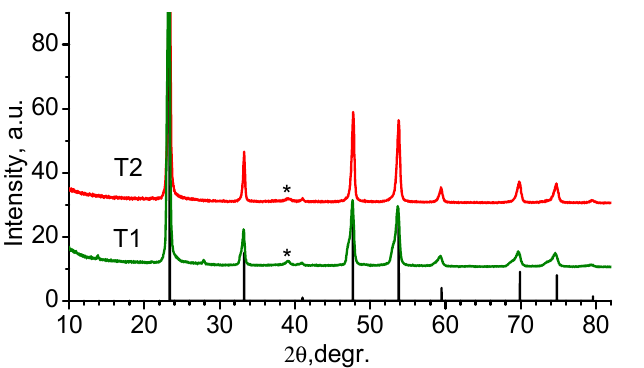
Figure 13. Diffraction curves from materials obtained with T1 and T2 synthesis; the line bar diagram corresponds to the positions and relative intensities of TiOF 2 diffraction maxima PDF-01-076-7831; * peak of the most intense TiO 2 reflex (rutile).